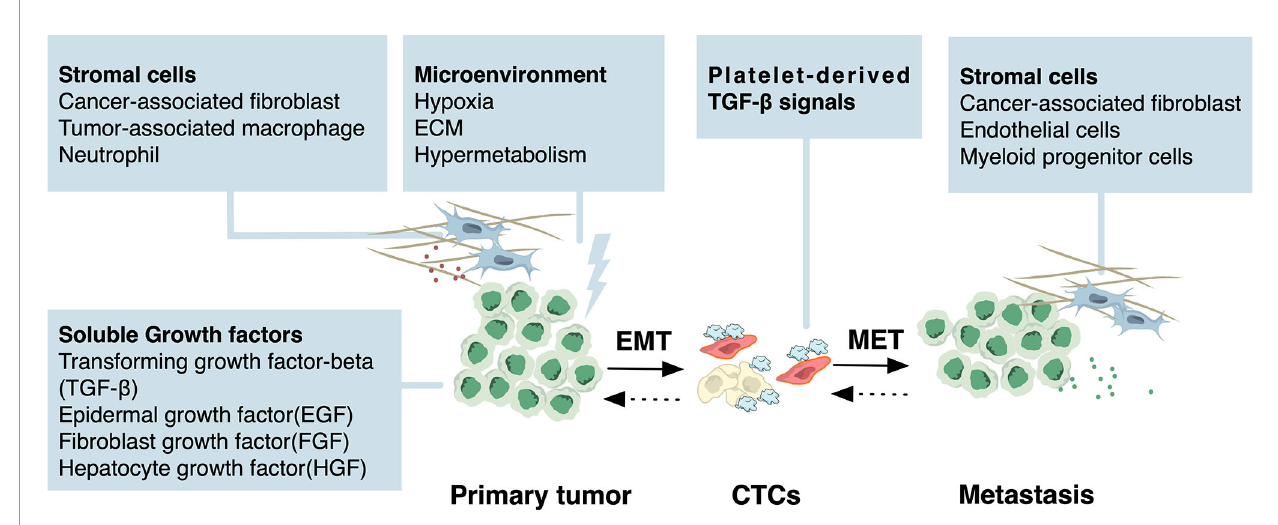
FIGURE 2 | Environmental stimuli of EMT and MET. Speci fi c environmental stimuli lead to the initiation of EMT program during cancer development and progression. In the microenvironment of the primary lesion, soluble growth factors including transforming growth factor beta (TGF- b ), epidermal growth factor (EGF), fi broblast growth factor (FGF), hepatocyte growth factor (HGF) secreted by stromal cells such as cancer-associated fi broblast, tumor-associated macrophage, and neutrophil activate several signaling pathways in cancer cells. These signaling pathways then regulate the EMT-related transcription factors (EMT-TFs) through epigenetic mechanisms. Hypoxic stress and altered metabolism from the microenvironment are also stimuli of EMT. For CTCs, in the absence of stroma-derived signaling cues that initiated EMT, platelet-derived TGF- b signals serve as the stimuli to sustain EMT. Although the external stimuli of MET are currently largely unknown, it has been proposed that MET can be triggered by stromal cells from the microenvironment including cancer-associated fi broblast, endothelial cells, and myeloid progenitor cells, or passively result from the absence of EMT-inducing signals from the primary tumor microenvironment.